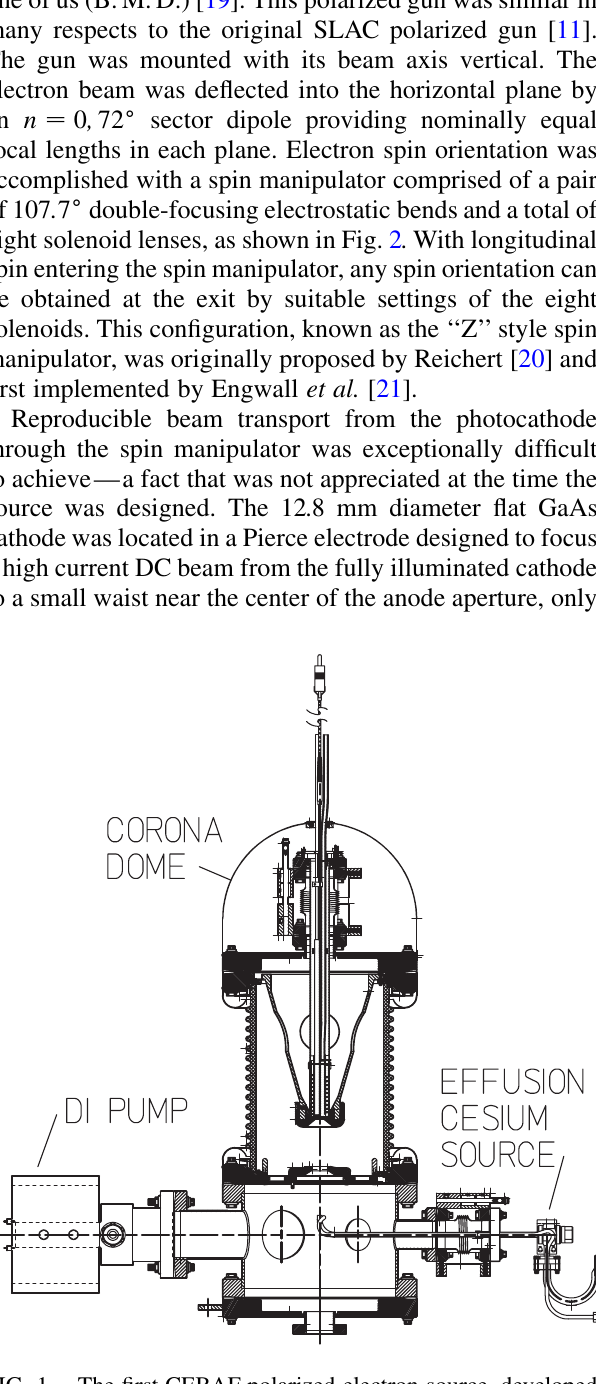
FIG. 1. The first CEBAF polarized electron source, developed in collaboration with the University of Illinois. The heater is shown inserted into the stalk cathode holder, and is removed during high-voltage operation.